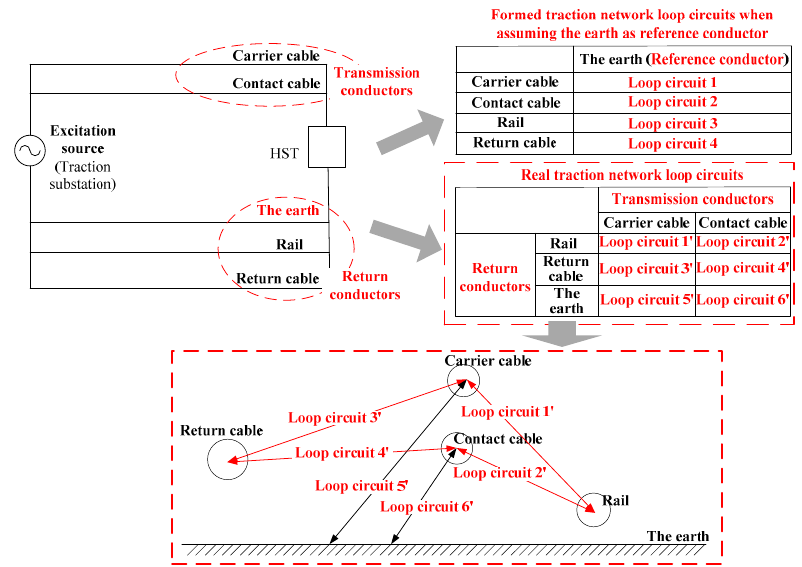
Figure 1. Diagram of the formed loop circuits when assuming the earth as the reference conductor and all the real loop circuits for a simple direct power supply system. In addition, since the currents of Loop circuits 3–4 are not generated by the excitation source, the deduced interlinkage flux of Loop circuits 3–4 and Loop circuits 1–2 is different from the inter linkage